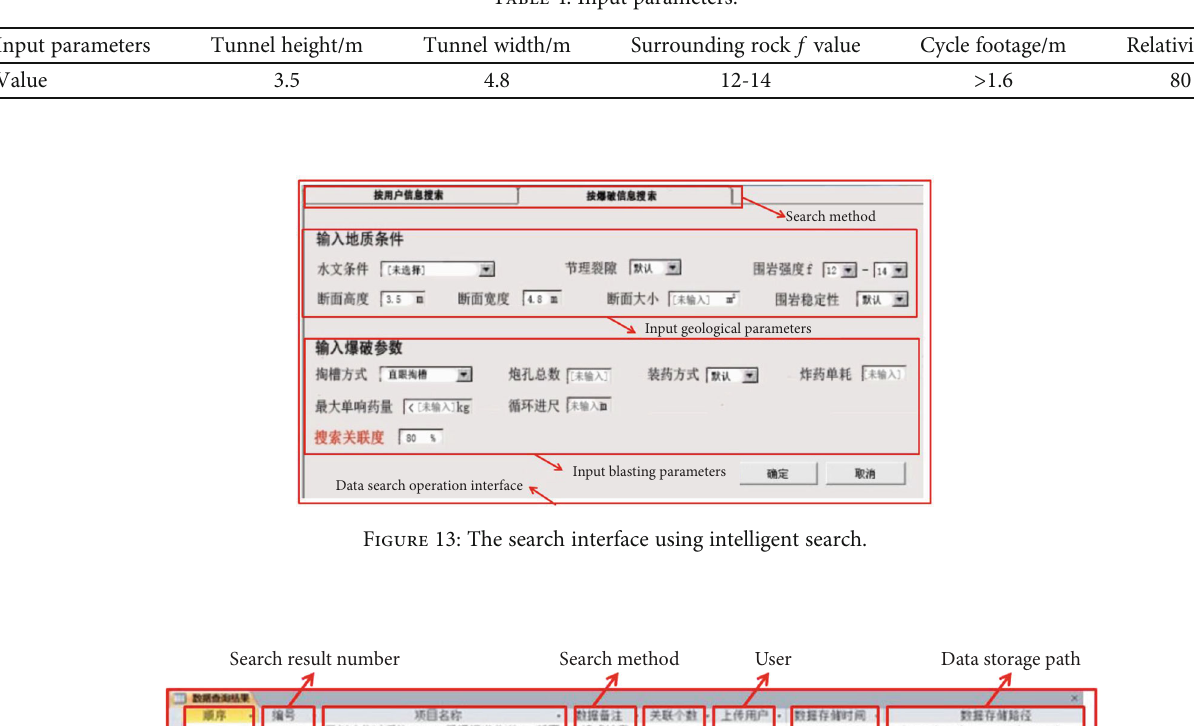
Table 4: Input parameters.